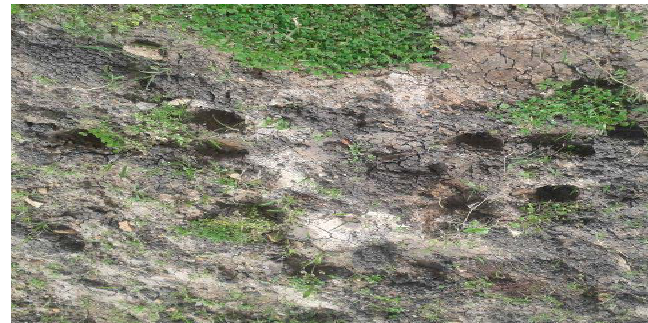
Figure 2. Photo of soil observed at Kidane-Mihret (Jimma) church site.